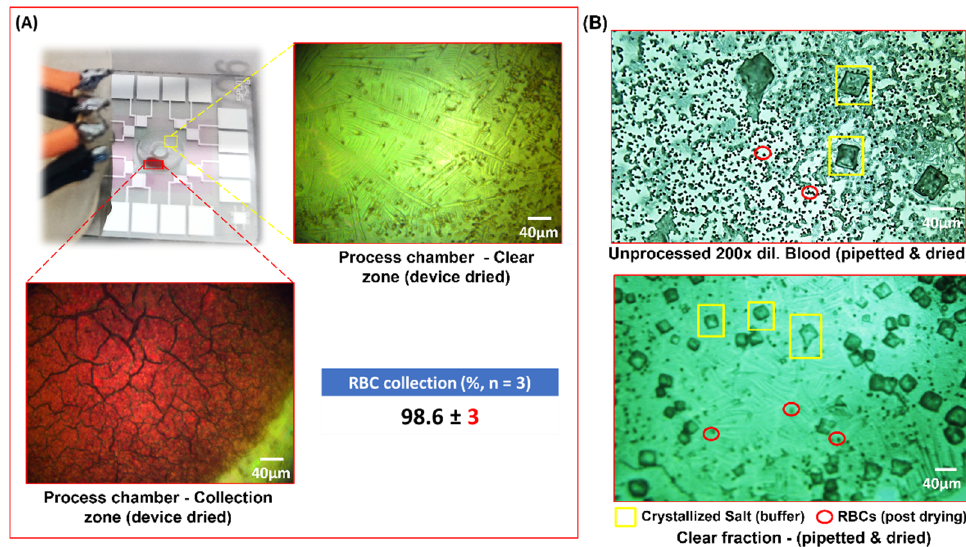
Figure 7. ( A ) Depicts the device post process of 20× diluted human blood. The deep-red patch was the area of accumulation of RBCs whereas the remaining zone appeared transparent. Note the 20× magnified images of the said zones post drying of the sample in the device. ( B ) Depicts the post-drying images from pipetted drops of the unprocessed samples (top-right) and processed 20× human blood (bottom-right). Note that the top-right image was imaged at 200× dilution since the cell density in a 20× diluted but unprocessed blood was too high and, therefore, would lack any discernible features.